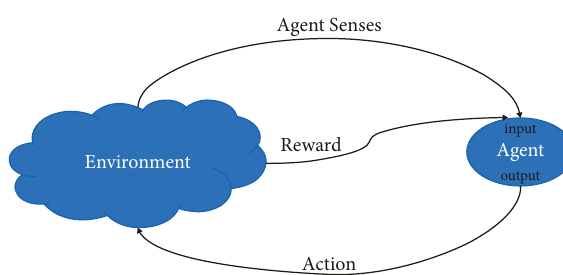
Figure 2: Standard Reinforcement Learning